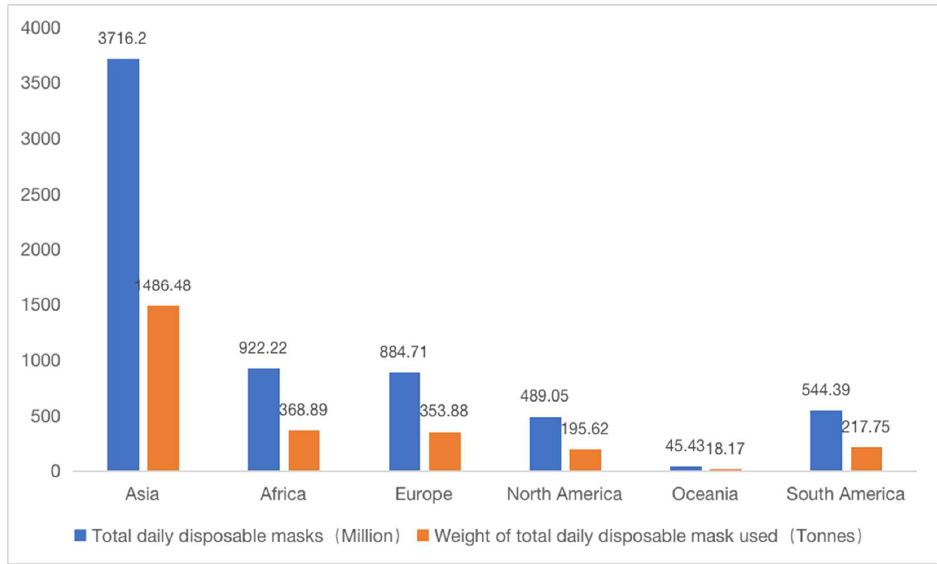
Figure 3. The estimated number of DMs used during the pandemic [30].